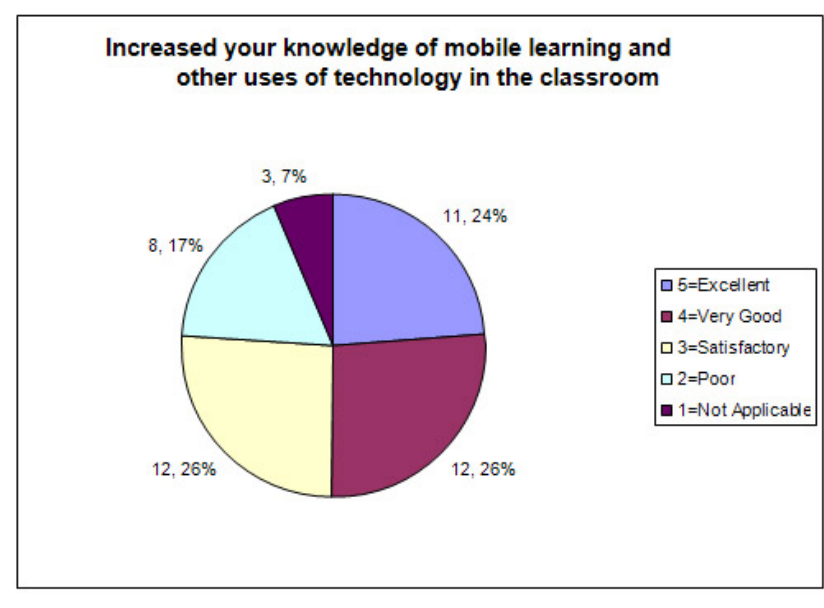
Figure 5. Mobile learning outcomes survey